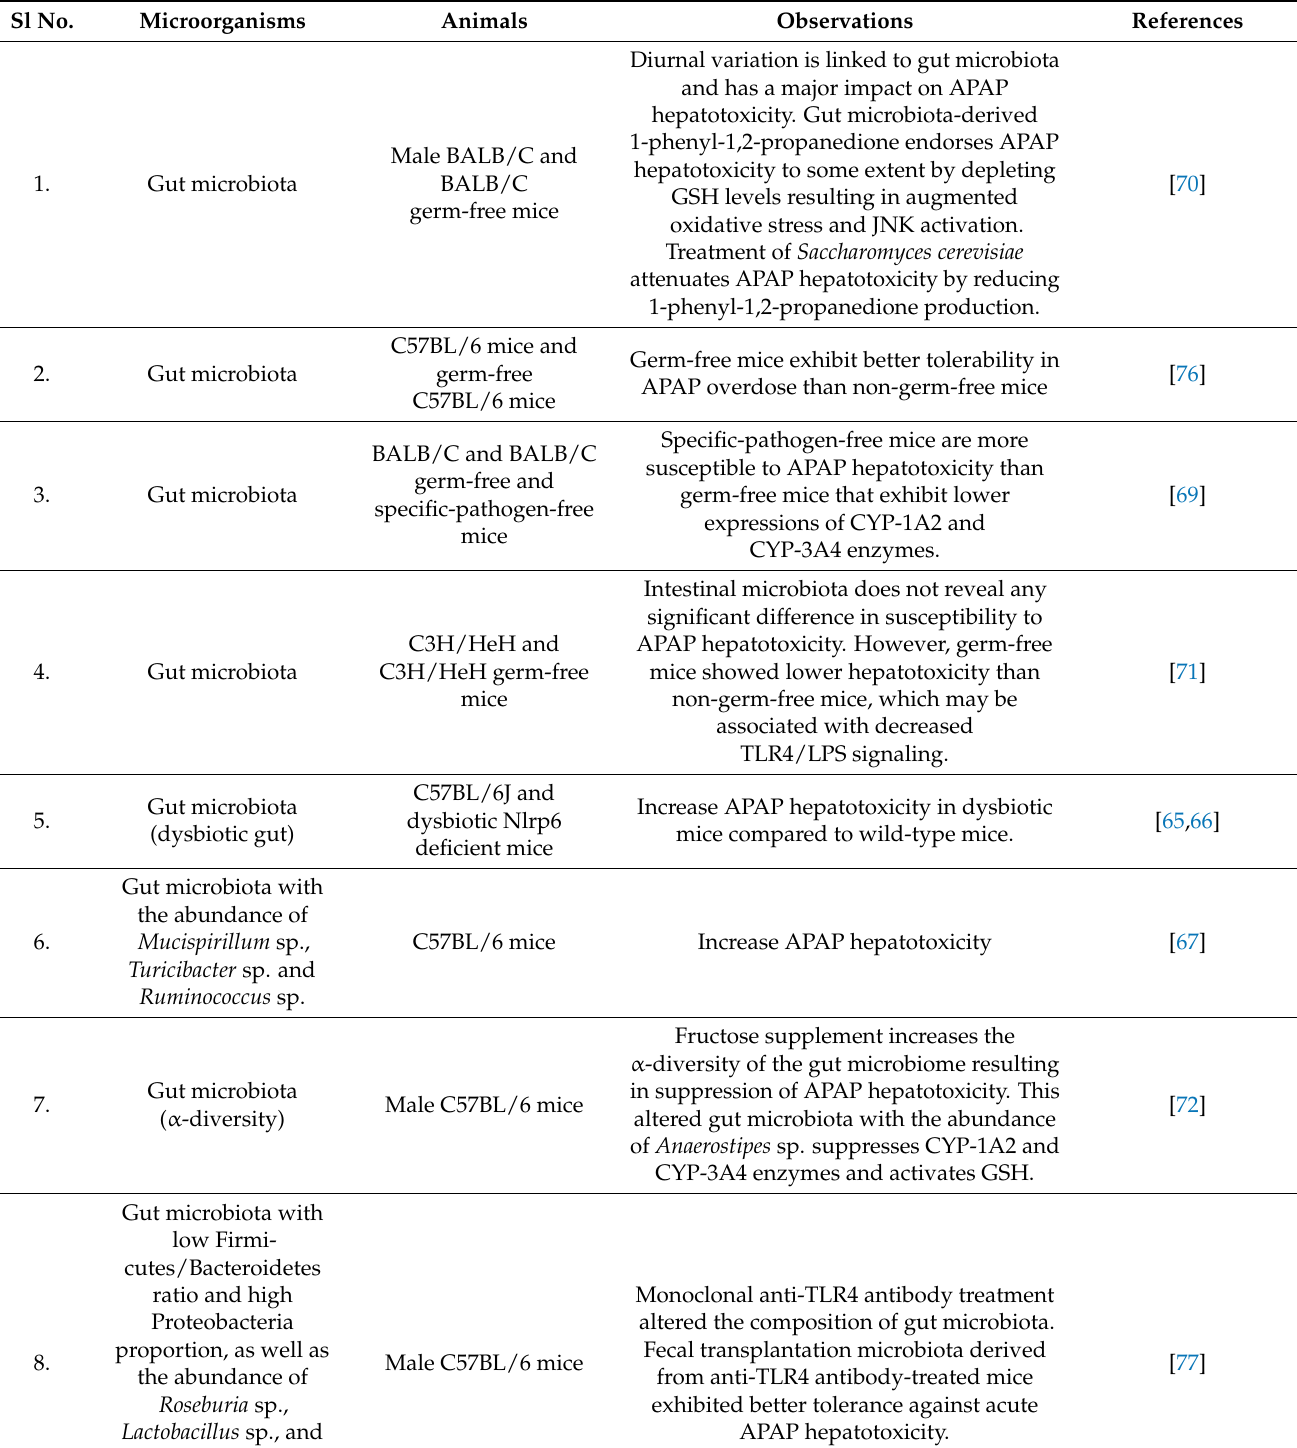
Table 1. A summary table representing how the composition of the gut microbiota differentially affects APAP